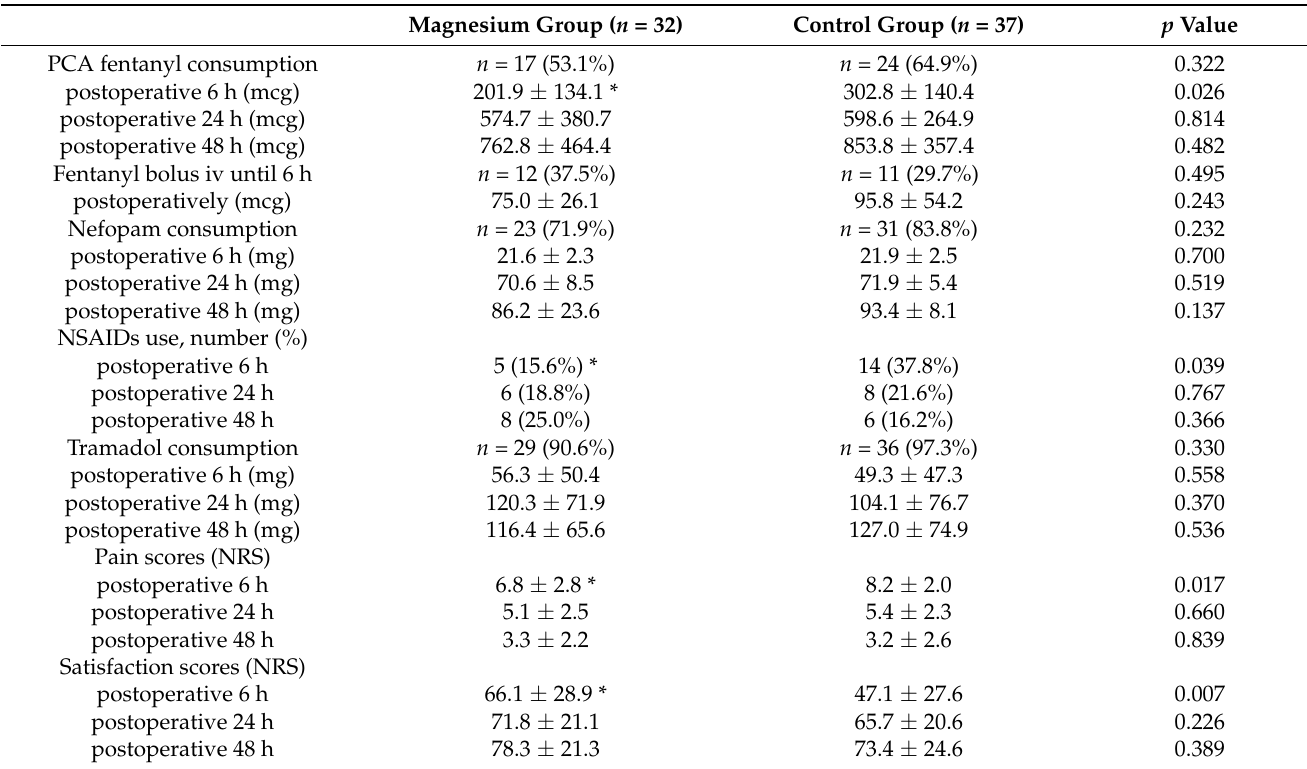
Table 3. Postoperative analgesic consumption and pain scores during the first 48 h after